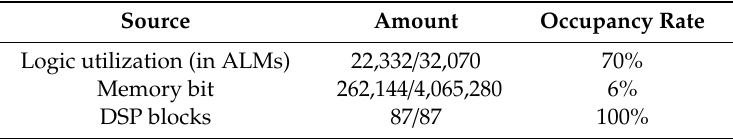
R-peak detection performance comparison between software implementation and hardware